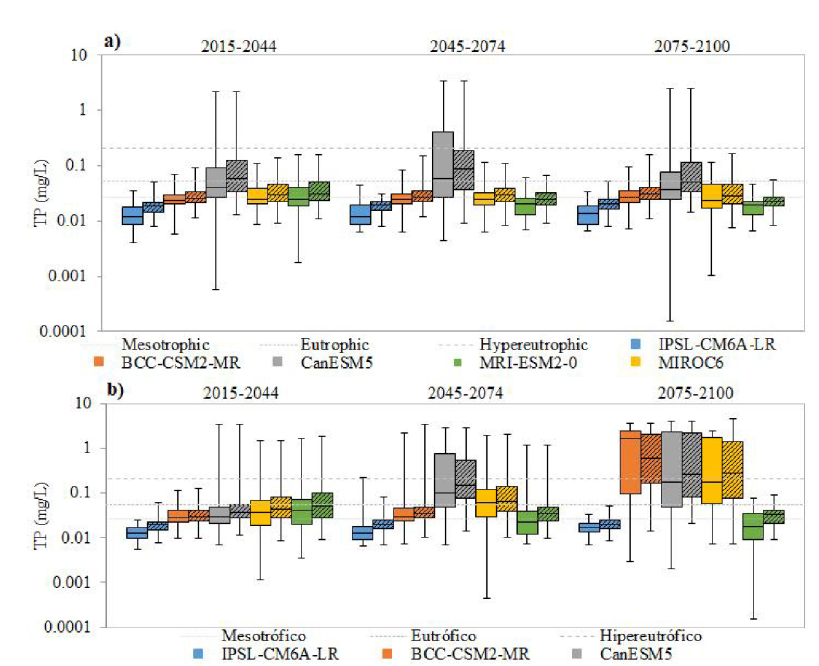
Figure 4. Probabilistic risks of trophic levels using the outputs of five different GCMs under a) SSP2-4.5 and b) SSP5-8.5, and three future periods.